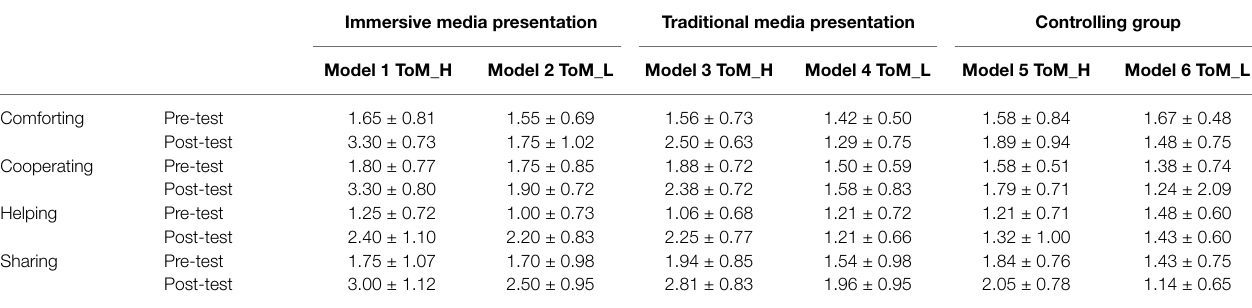
TABLE 2 | Results of moderating effect of ToM in the relationship between media presentation and prosocial